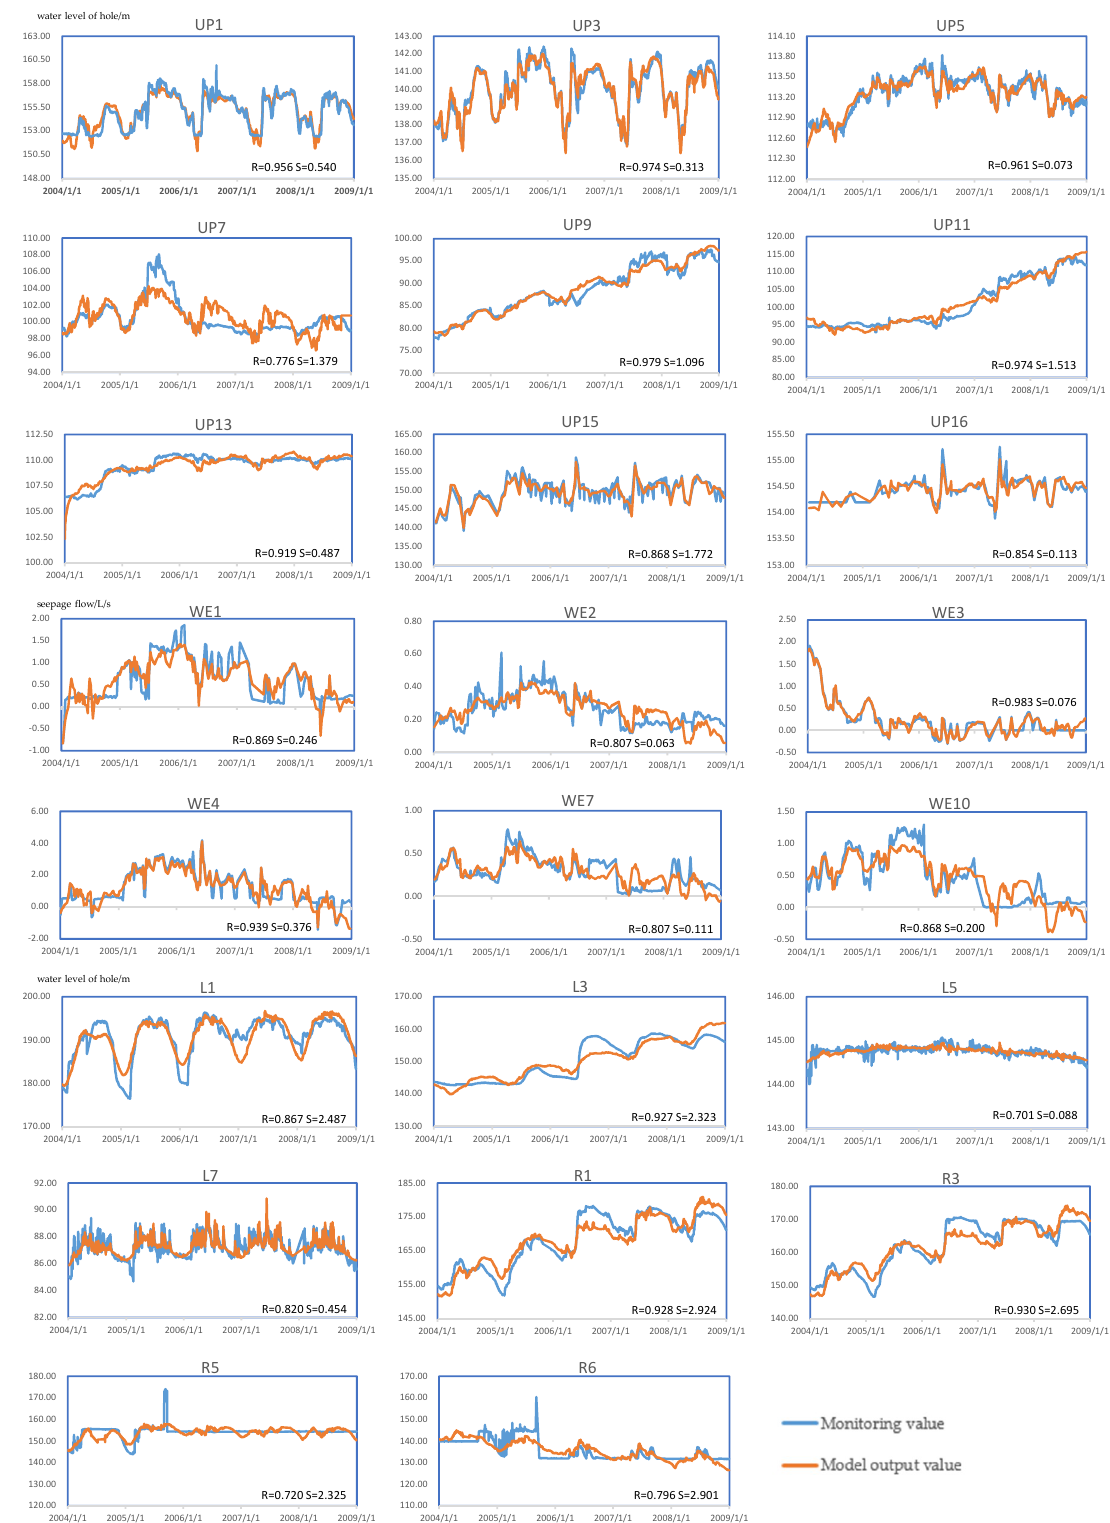
Figure 7. The variation curves between the monitoring values and the mode output values 278